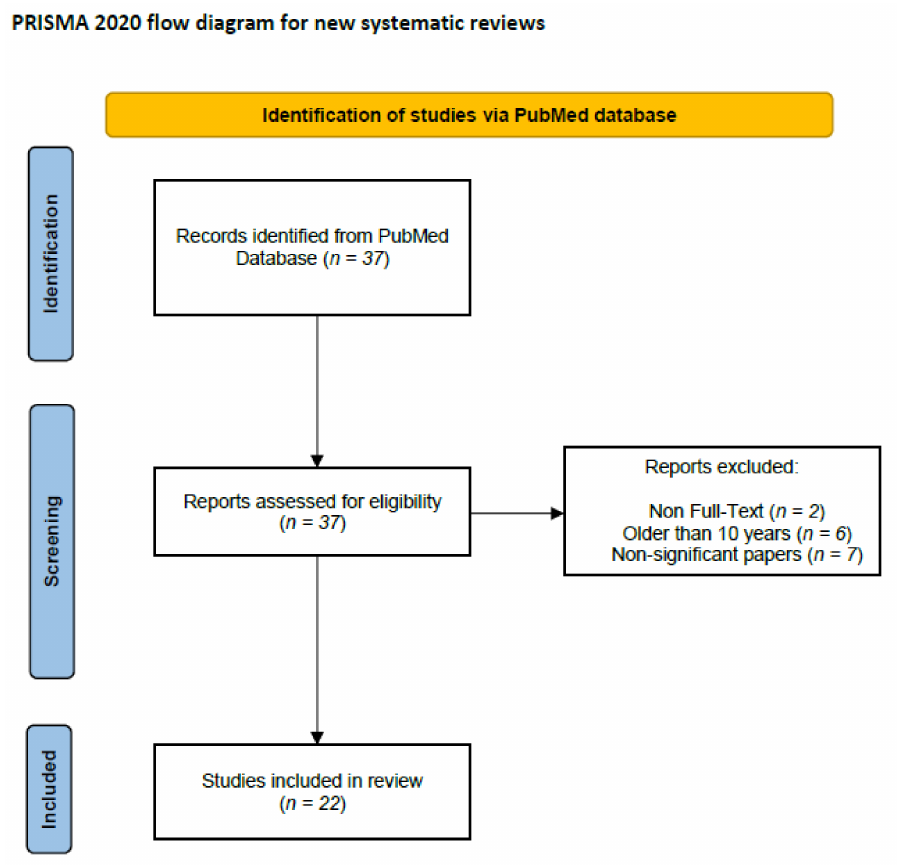
Figure 4. Schematic illustration of articles included in the